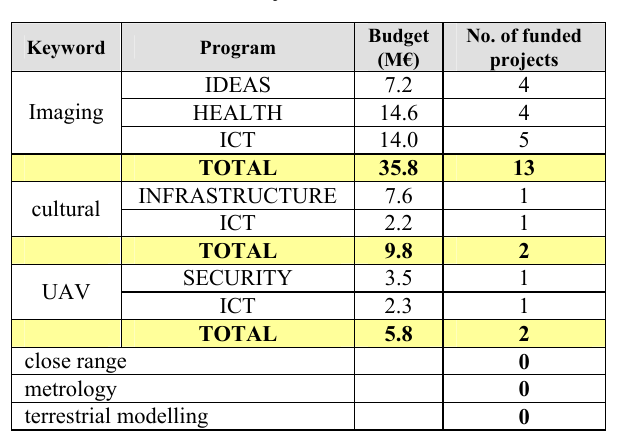
Table 3. EU FP7 funded Projects – General